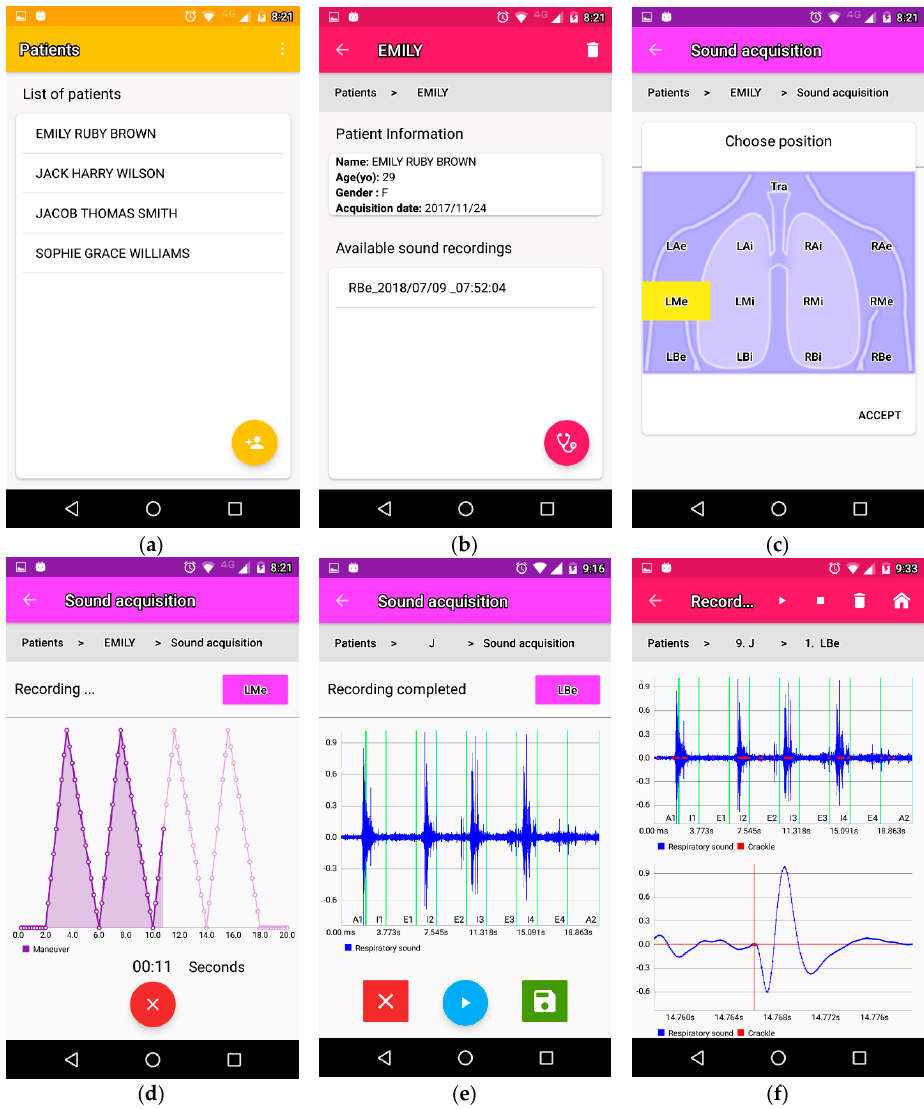
Figure 7. Different activities of the mobile app. ( a ) Patient list activity. ( b ) Patient activity. ( c ) Selection of auscultation point activity. ( d ) Sound recording activity. The area under the curve fills during the acquisition to provide a visual aid. ( e ) Activity to replay, discard or save the recording. ( f ) Analyze patient activity. The upper graph displays the whole recorded respiratory sound and the detected locations of crackles. This graph is fixed. The bottom graph displays a segment of the signal selected by the user so that it can be zoomed, scrolled and tactile select a data point to know its exact time location on the